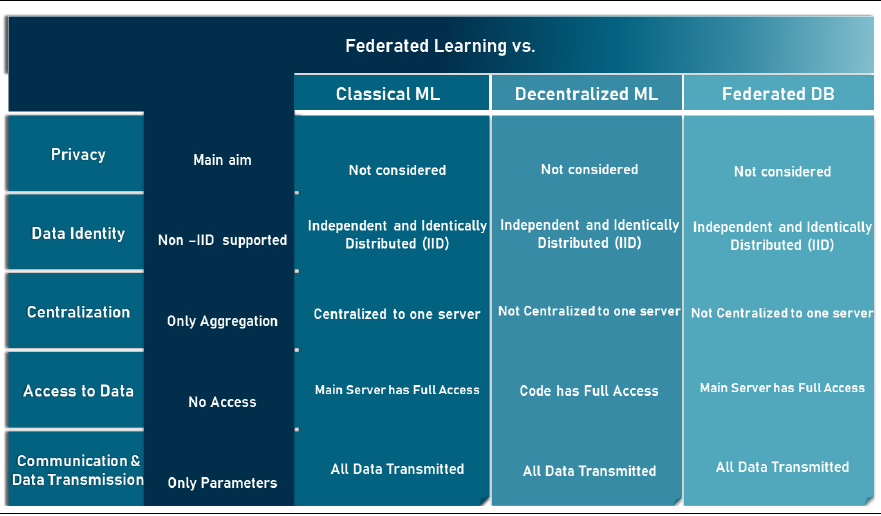
Figure 6. Borderlines between FL, ML, decentralized ML and federated